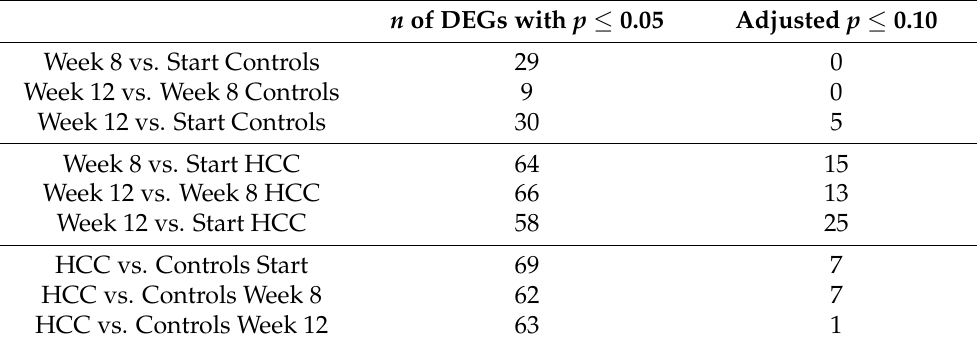
Table 2. Differentially Expressed Genes in Both Groups (HCC and Controls). n of DEGs with p ≤ 0.05 Adjusted p ≤